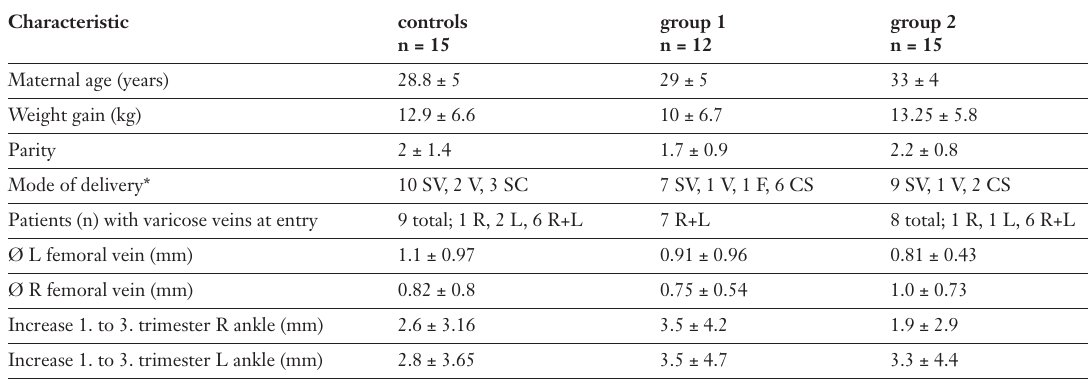
Baseline characteris- tics in the study population.